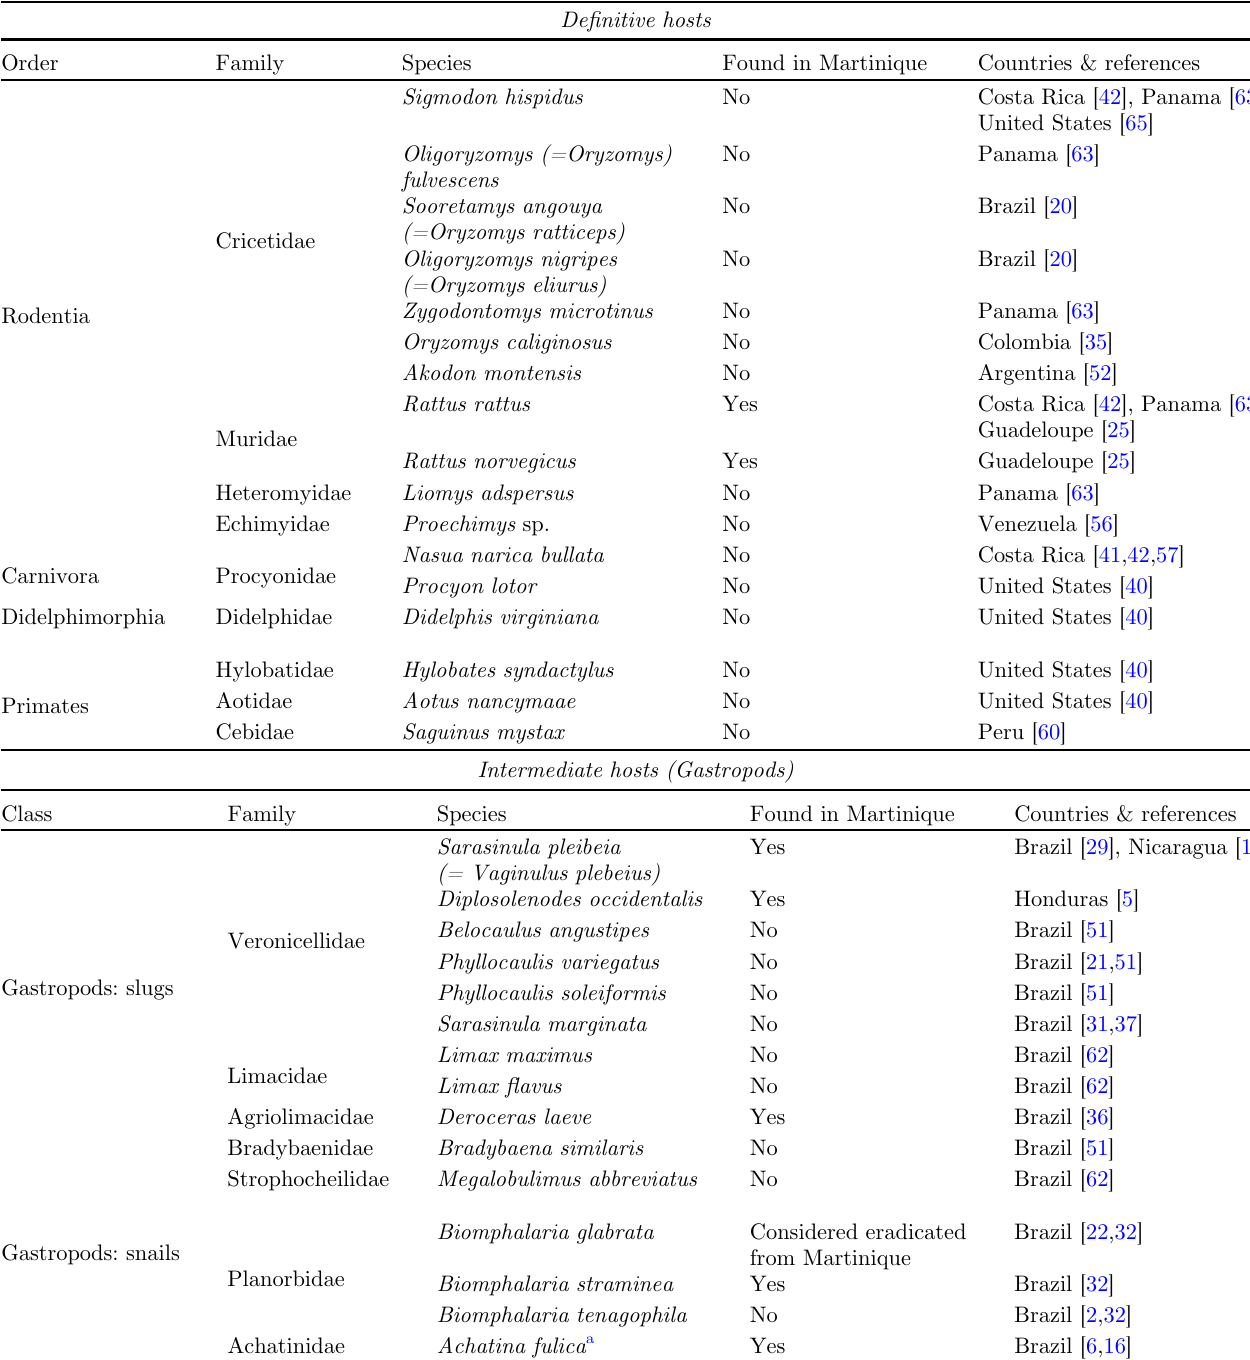
Table 3. A. costaricensis de fi nitive and intermediate hosts described in the literature and comparison with the species found in Martinique. The de fi nitive hosts of A. costaricensis in Martinique could be the rodent species Rattus rattus and Rattus norvegicus . The intermediate hosts could be Sarasinula plebeia , Diplosolenodes occidentalis , Deroceras laeve , and Biomphalaria